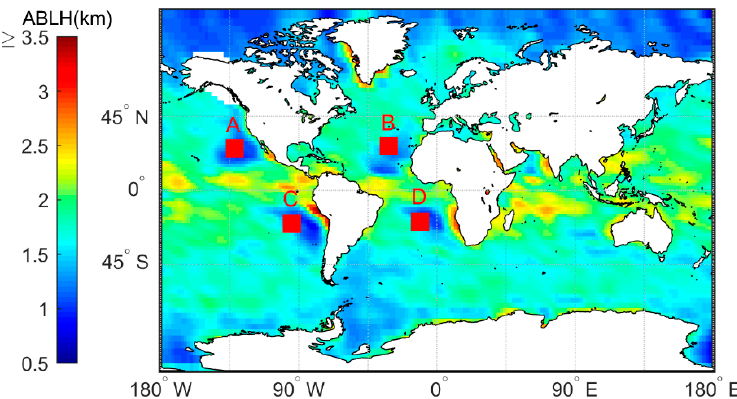
Figure 3. Annual marine boundary layer height (MBLH) based on the 2007–2011 CDAAC “atmprf” bending angle products. The small red boxes (A, B, C, D) in the figure have a range of 10 ◦ × 10 ◦ .